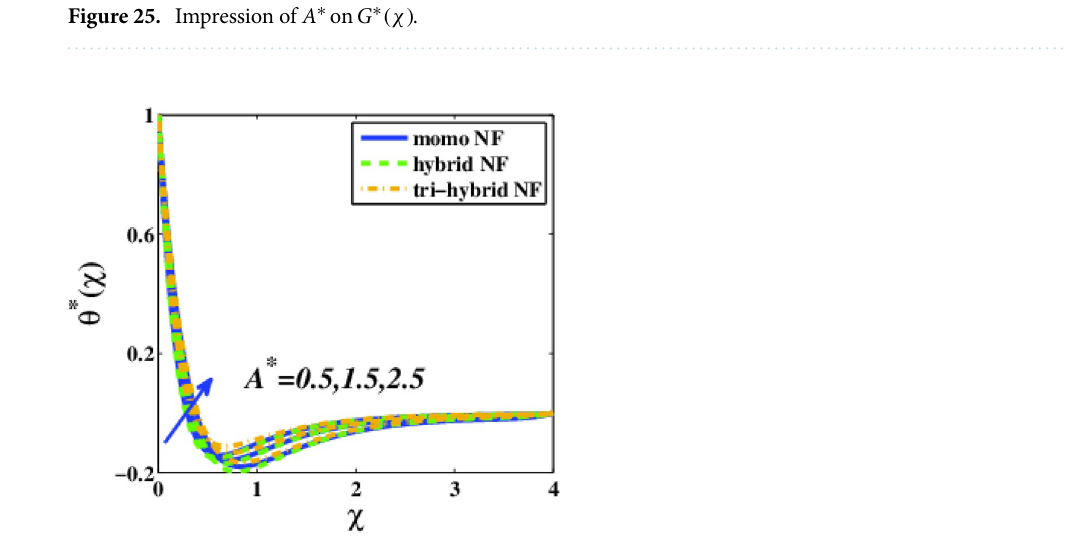
Figure 26. Effect of A ∗ on θ ∗ (χ) .